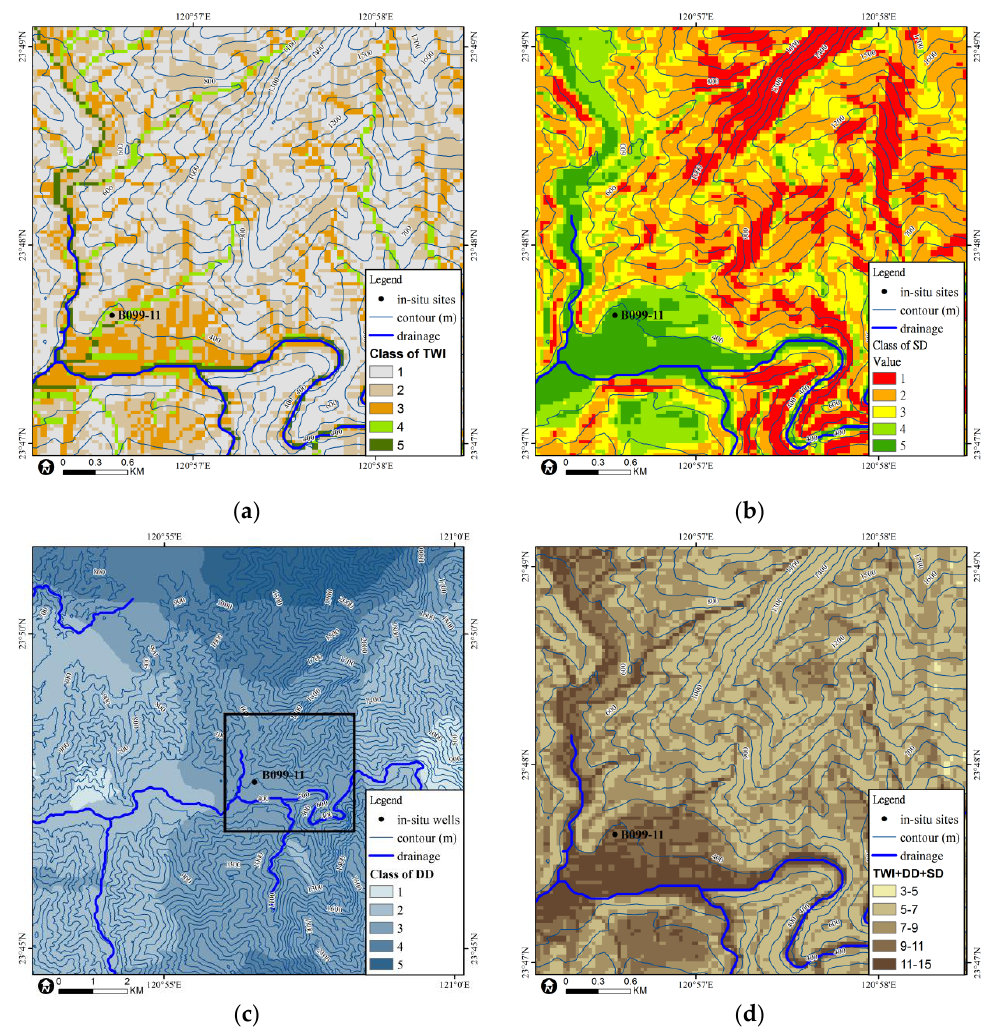
Figure 8. Groundwater potential was initially described by geomorphic thematic maps of TWI, SD, and DD. A case near B099-11 site: ( a ) map of TWI; ( b ) map of SD; ( c ) map of DD; ( d ) map of weighted sum with TWI, SD, and DD.